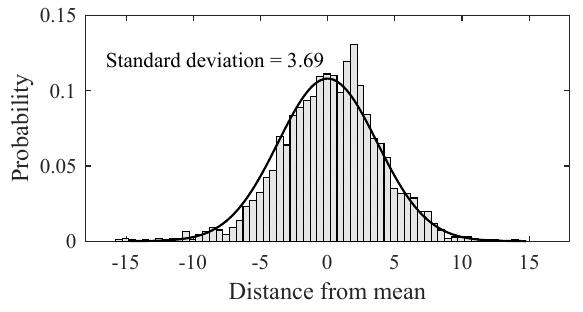
Figure 11. Means and 1 σ standard errors of UCATS ozone along the different sections of RF05. Shading denotes profiles in the Southern Hemisphere.